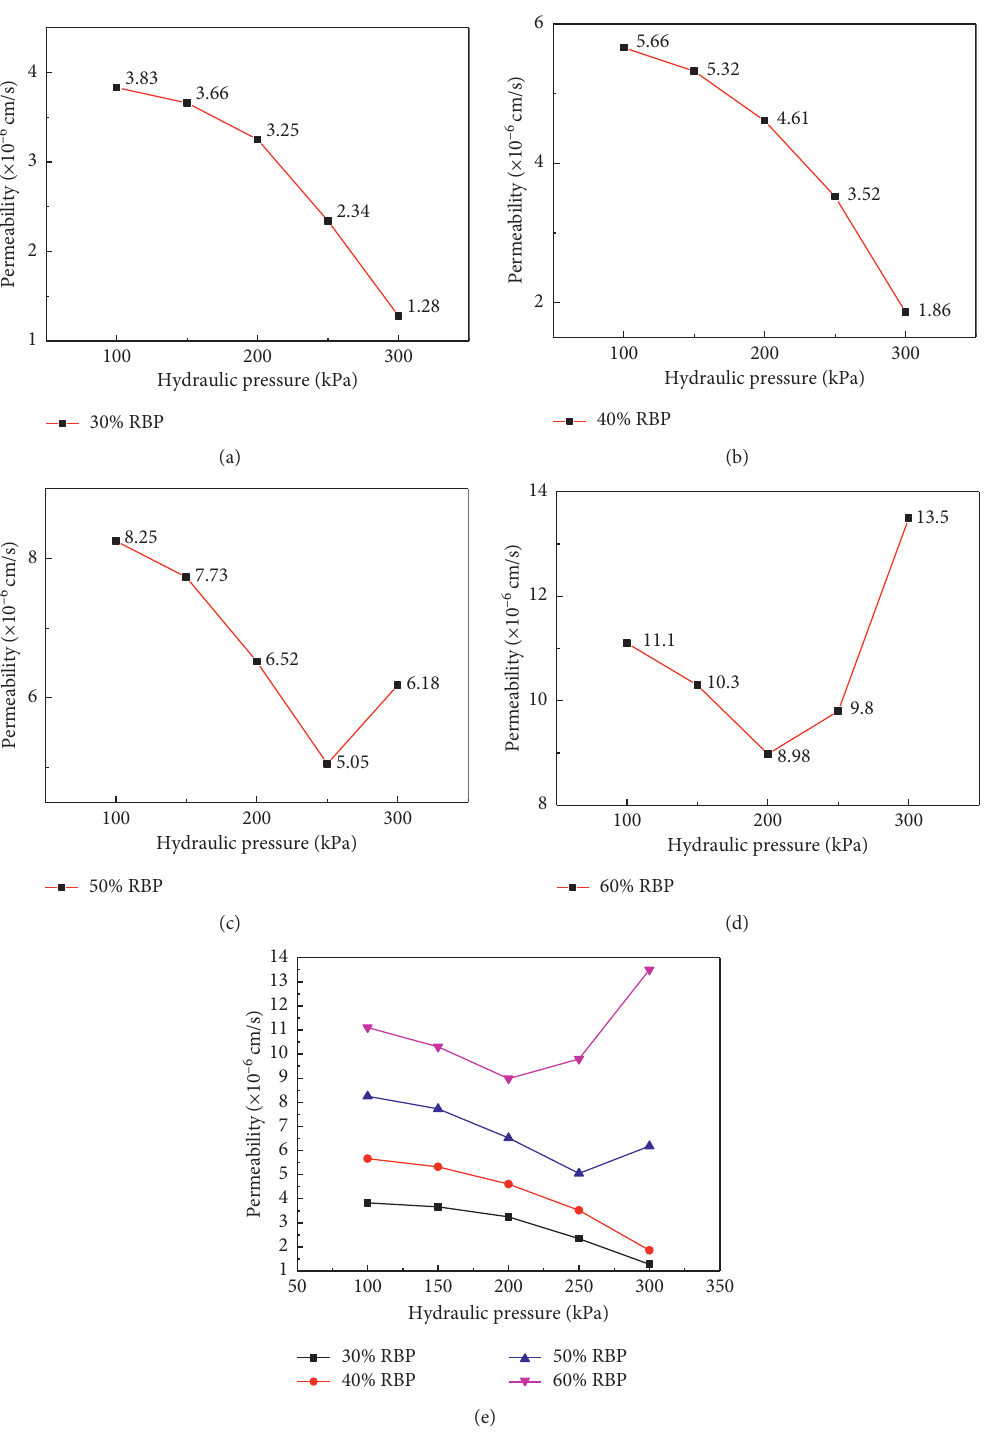
Figure 9: Curve of hydraulic pressure and permeability of soil-rock mixtures: (a) RBP � 30%; (b) RBP � 40%; (c) RBP � 50%; (d) RBP � 60%; (e)